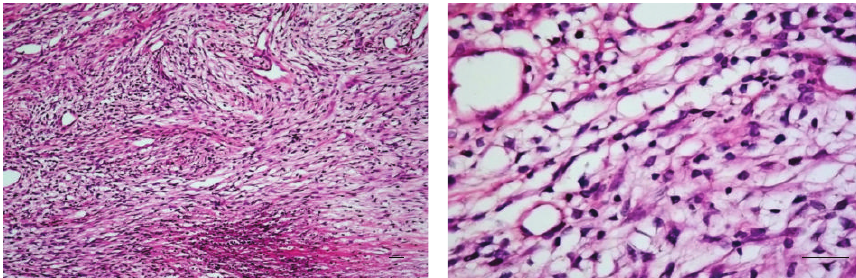
Figure 2: Histopathology samples stained with hematoxylin and eosin revealed a chronic eosinophilic granuloma consisting of densely eosinophilic material representing remnants of fragmented collagen bundles and degenerate eosinophils which have released their granules to theinterstitium.At theperiphery ofthegranuloma, mainly differentiated fibrovascular tissuecan beseen with someeosinophilicgranulocytes intermingled with small numbers of lymphocytes, macrophages, plasma cells, and neutrophils (scale bars = 100 𝜇 m).